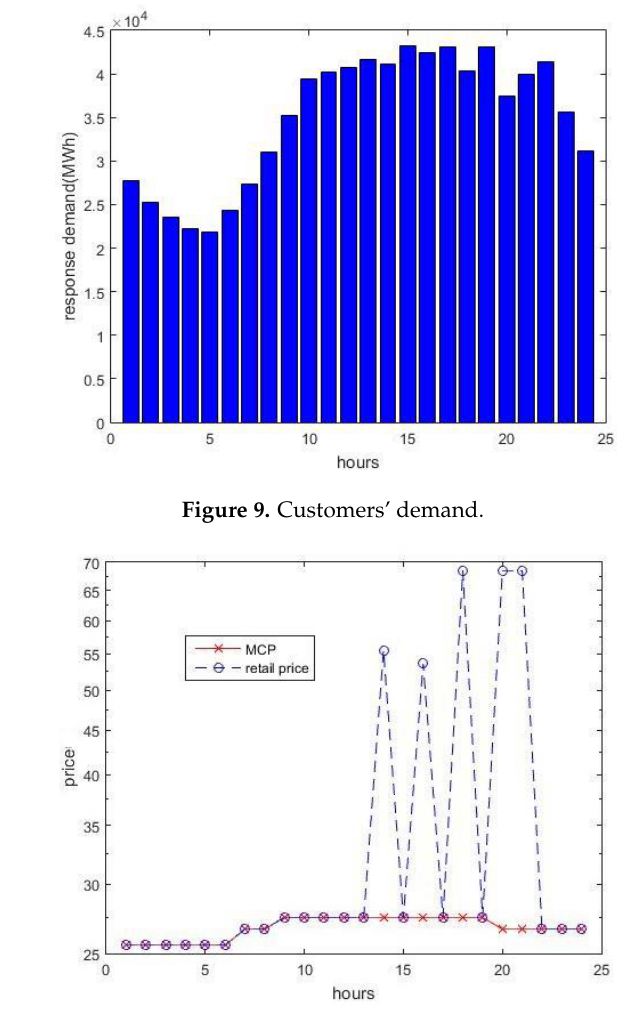
Figure 10. MCP vector and retailer’s sales price ($/MWH) .